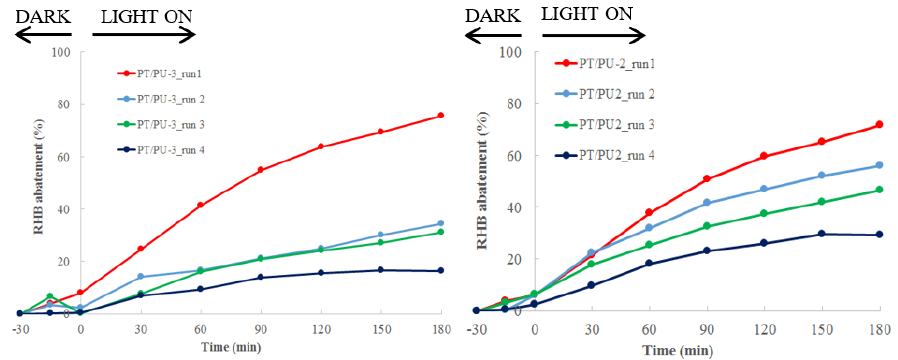
Figure 4. Reuse of PT/PU-2 ( left ) and -3 ( right ) for RHB abatement after washing with acetone.